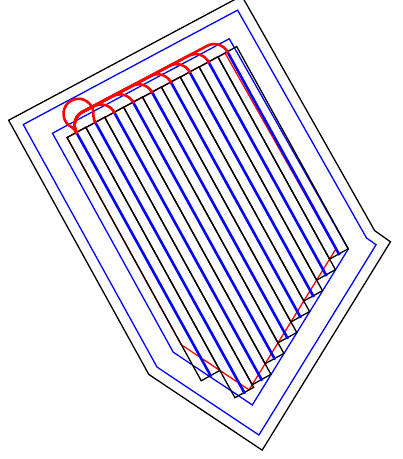
Figure 6. An illustrative example of track-to-track connectors (red curved paths) from one track end to all other tracks’ end.